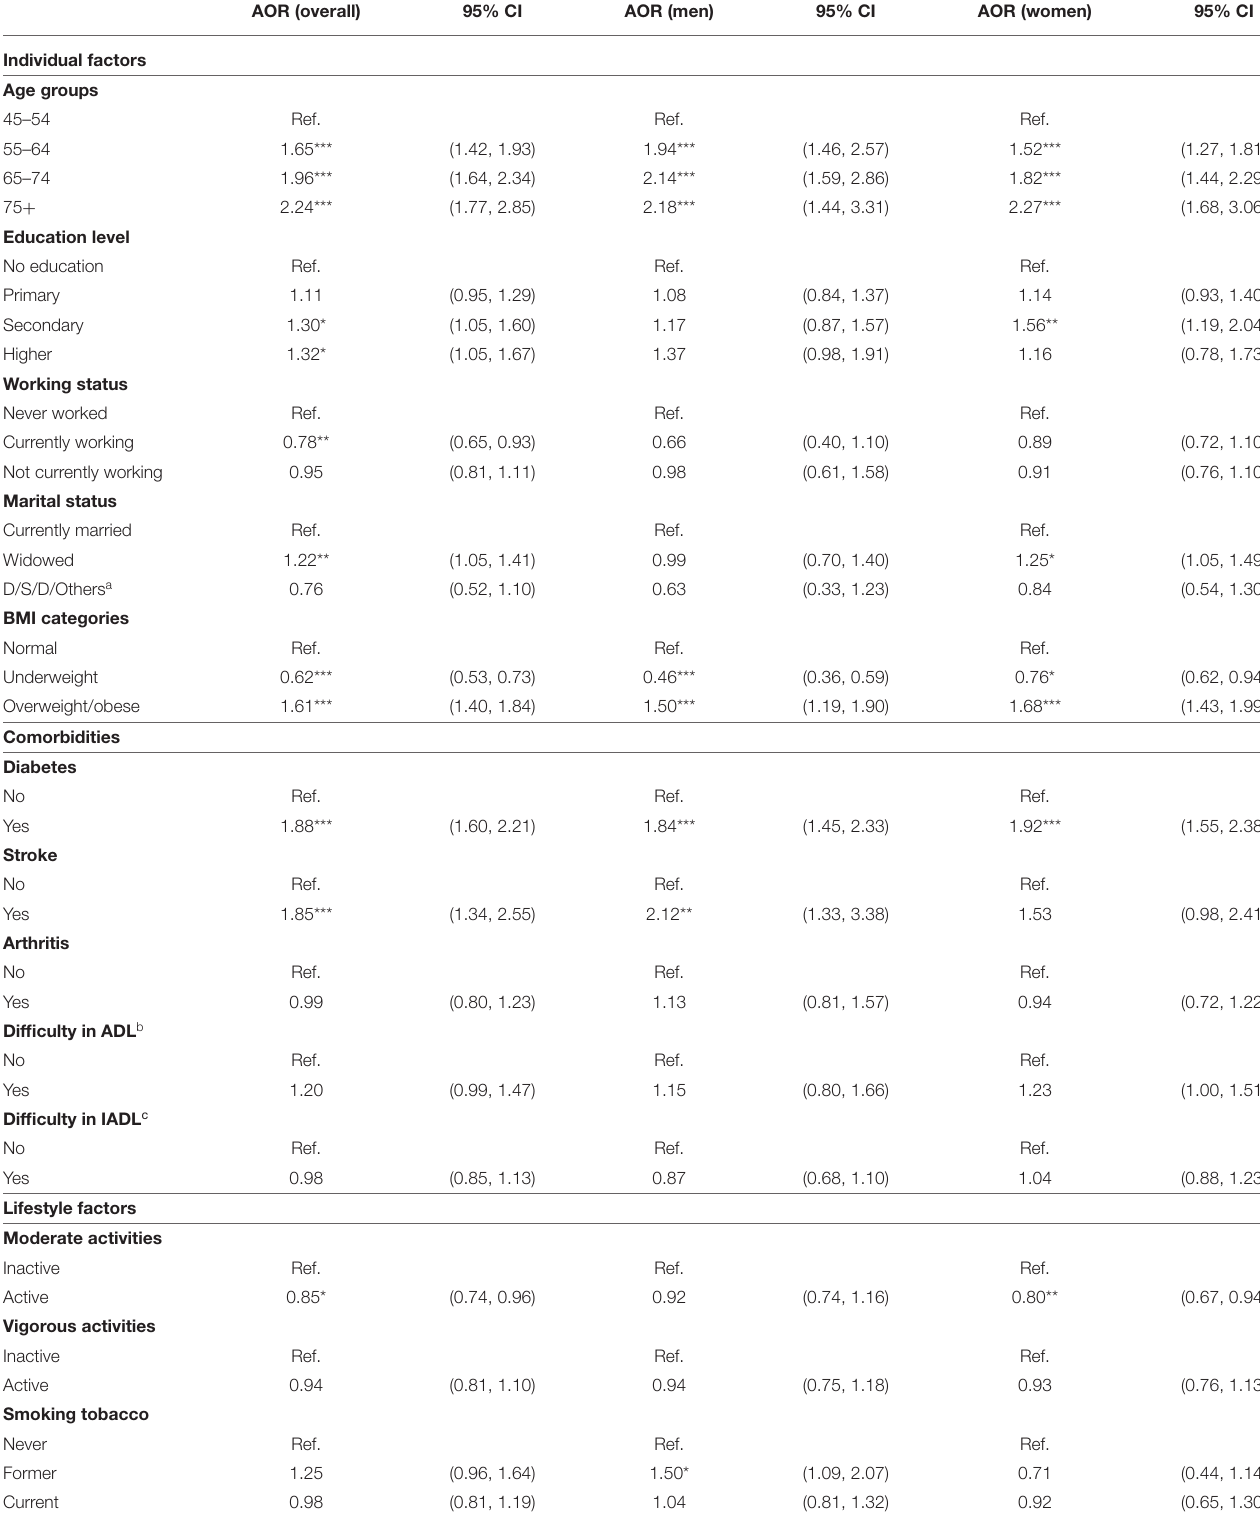
TABLE 3 | Logistic regression results for currently taking treatment of hypertension among older adults, India, LASI,